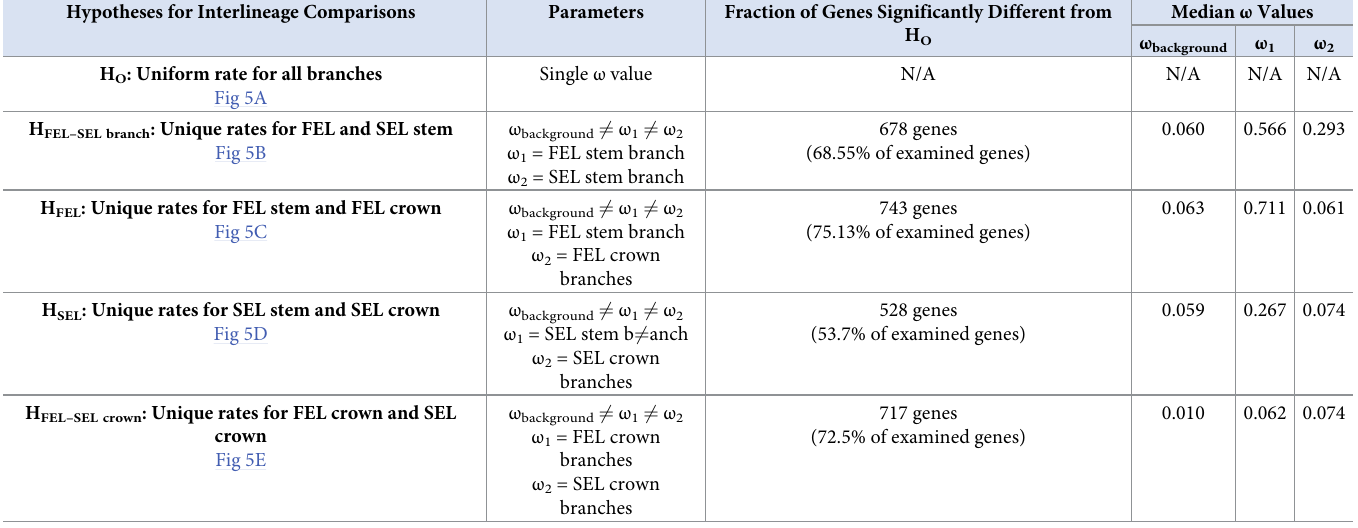
Table 1. Rate of sequence evolution hypotheses and